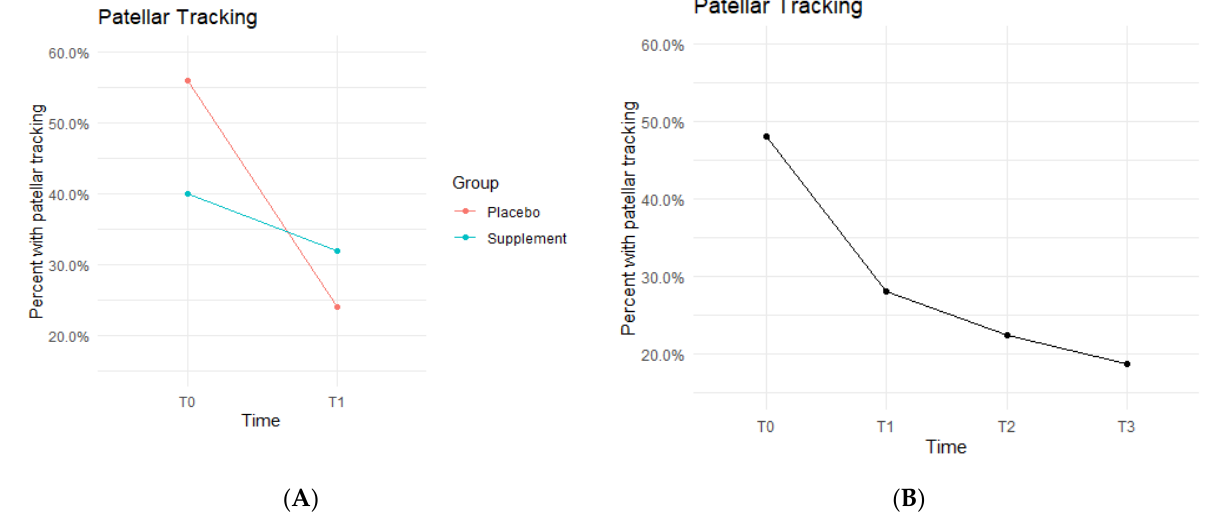
Figure 7. Patellar Tracking Changes Over Time. Average percentages of participants with poor patellar tracking were graphed on a plot. ( A ) compares Supplement vs. Placebo from T0 to T1. ( B ) shows averages for the entire cohort as a whole at times T0, T1, T2, and T3. Only affected knees were included in the data. Table 5. Best “Effect” Estimate of Patellar Tracking. Fixed effects from multilevel model of patellar tracking at times T0 vs. T1.